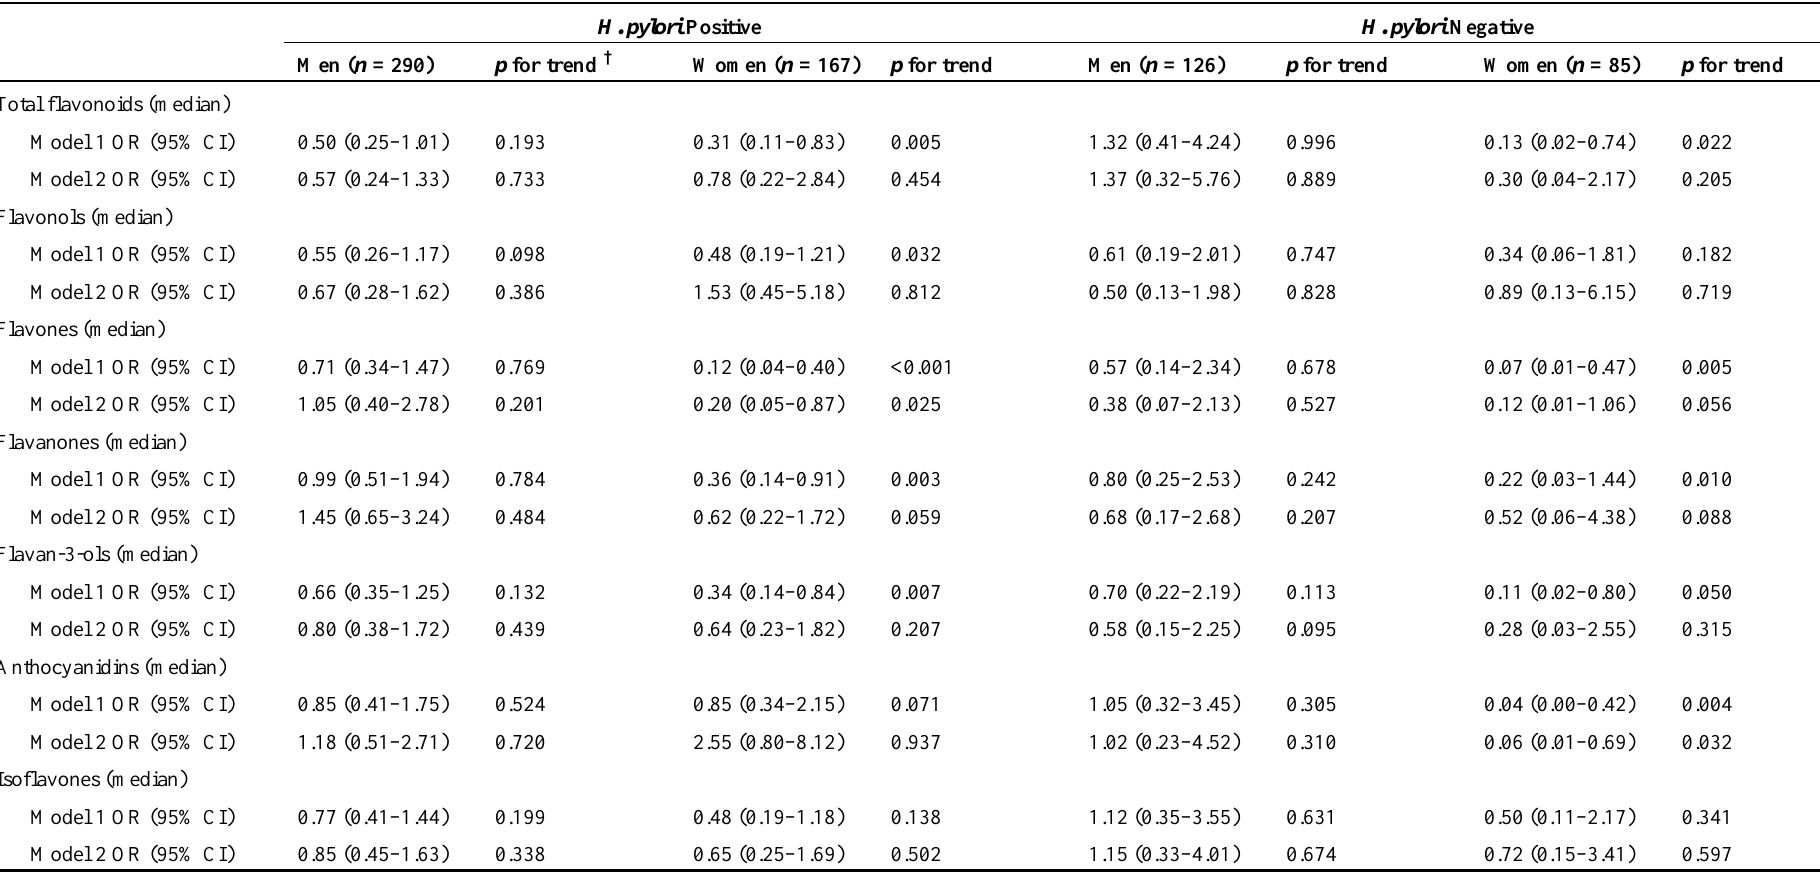
Table 3. ORs and 95% CIs of gastric cancer by tertiles of dietary flavonoids stratified by H. pylori